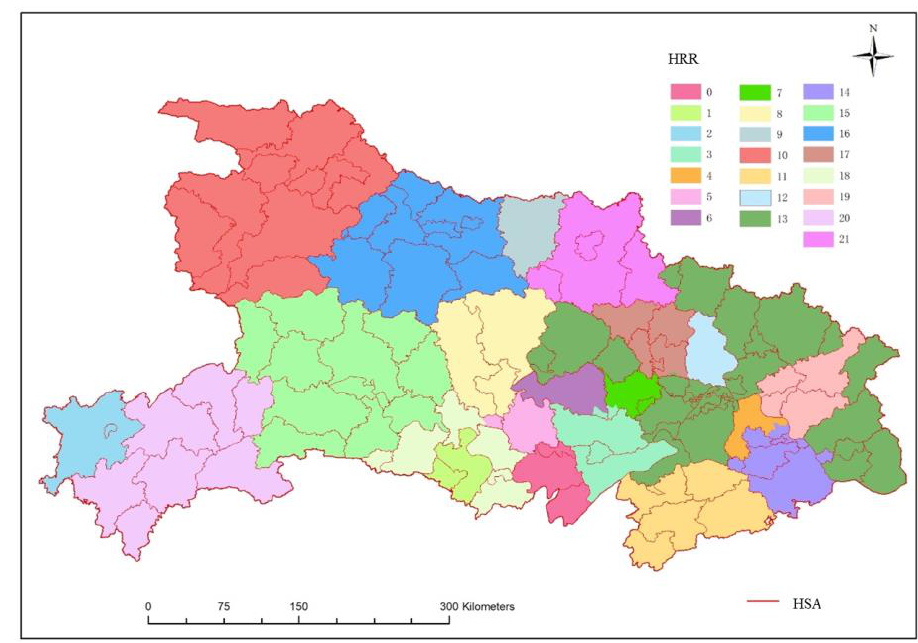
Figure 8. The distribution of maternal treatment center and subcenters.